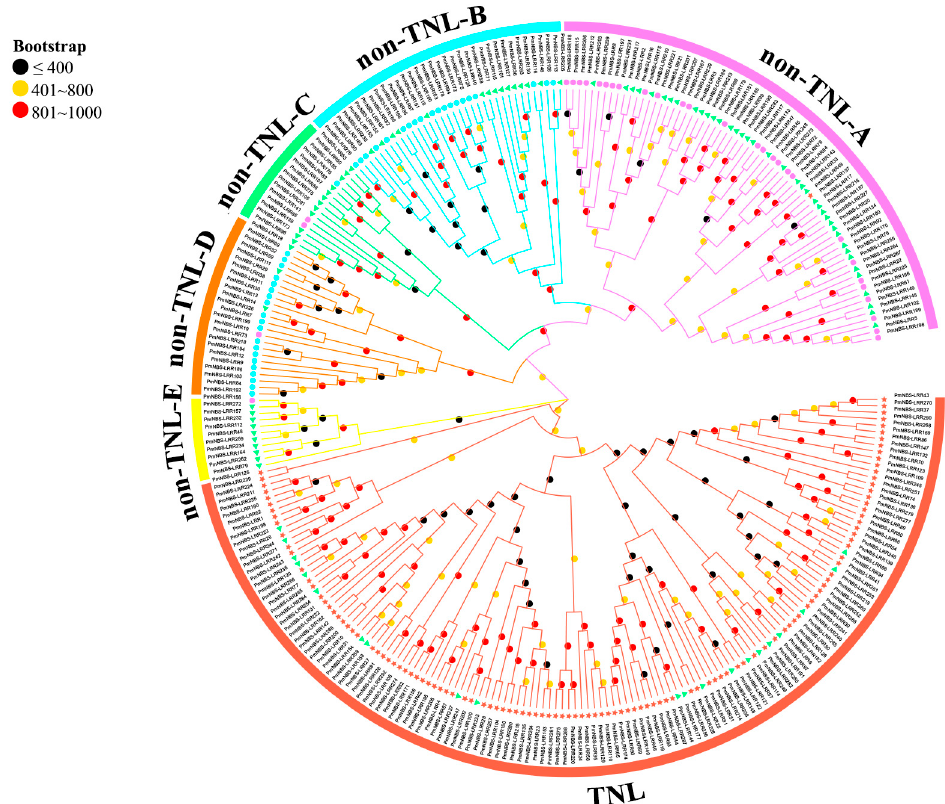
Figure 1. Phylogenetic tree of P. massoniana NBS-LRR disease resistance genes based on NBS domain regions. A maximum likelihood (ML) phylogenetic tree with 1000 bootstrap repeats was constructed with MEGA7.0. Stars, triangles, circles, and squares represent TNL, NL, RNL, and CNL predicted proteins, respectively. The bootstrap values are represented by different colored circles on the branches.